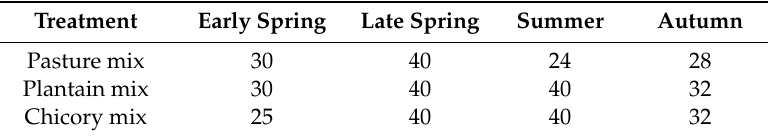
Table 2. Stocking rates (no. of sheep / ha) used in each